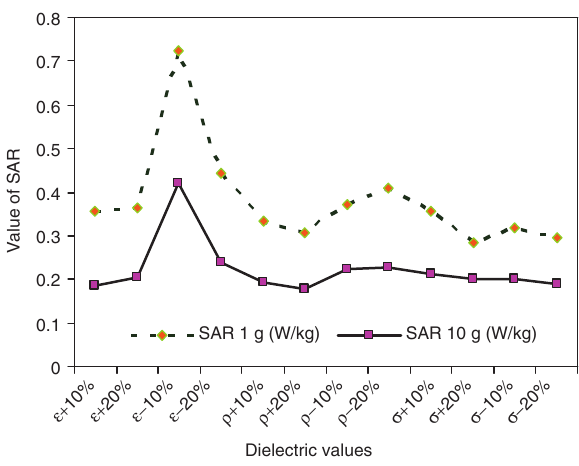
Figure 2 Deviation of the peak of unaveraged SAR in different dielectric properties of Rogers R04003 (loss free) substrate at 1800 MHz.